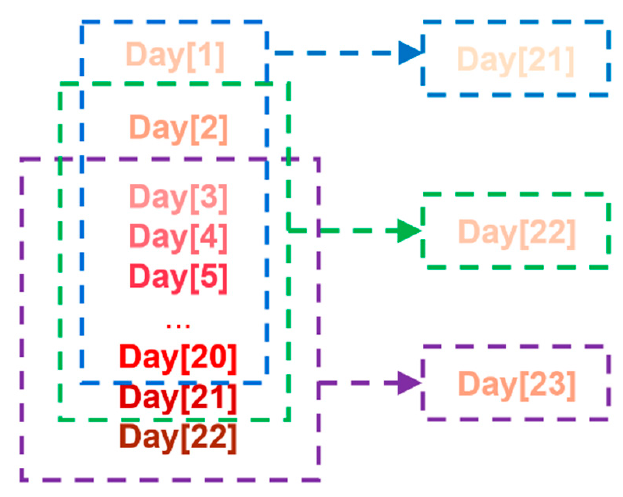
Figure 5. Rolling time window for forecasting.